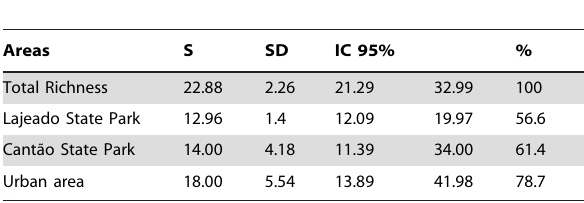
SD - Standard Deviation, CI: Confidence interval. S% - Percentage of total richness estimated for each